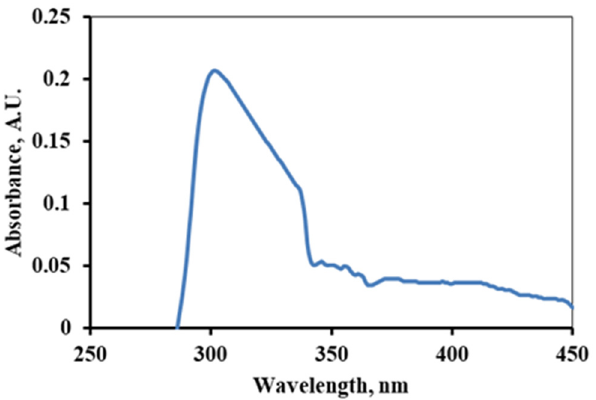
Figure 3. Lycopsamine as reference alkaloid participating in the different qualitative chemical re- actions.